Question: Condense the content of this figure into a single sentence.
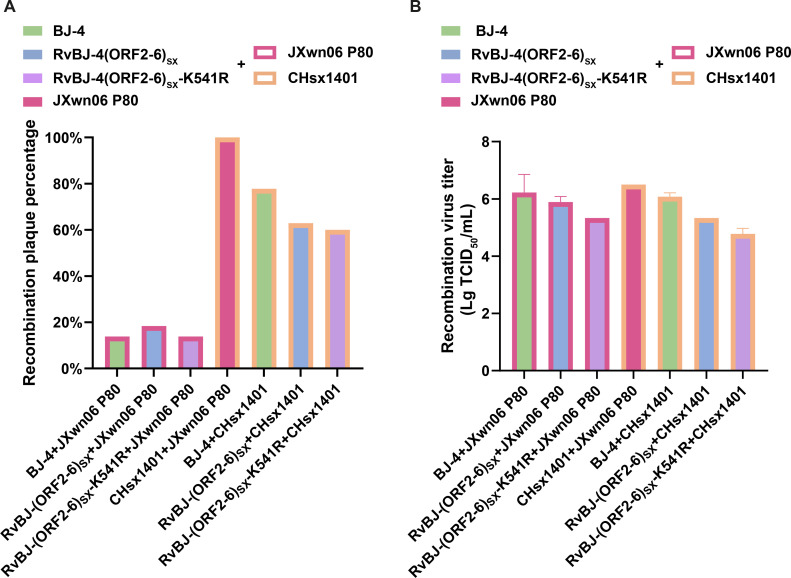
Answer: Summary of recombination outcomes. ( A ) Percentage of recombinant plaques identified in each co-infection group. ( B ) Viral titers of the co-infection culture supernatants. The colors of the column fill and border correspond to the two strains involved in the co-infection. Note: statistical comparison markers are omitted for clarity due to the large number of comparison groups.